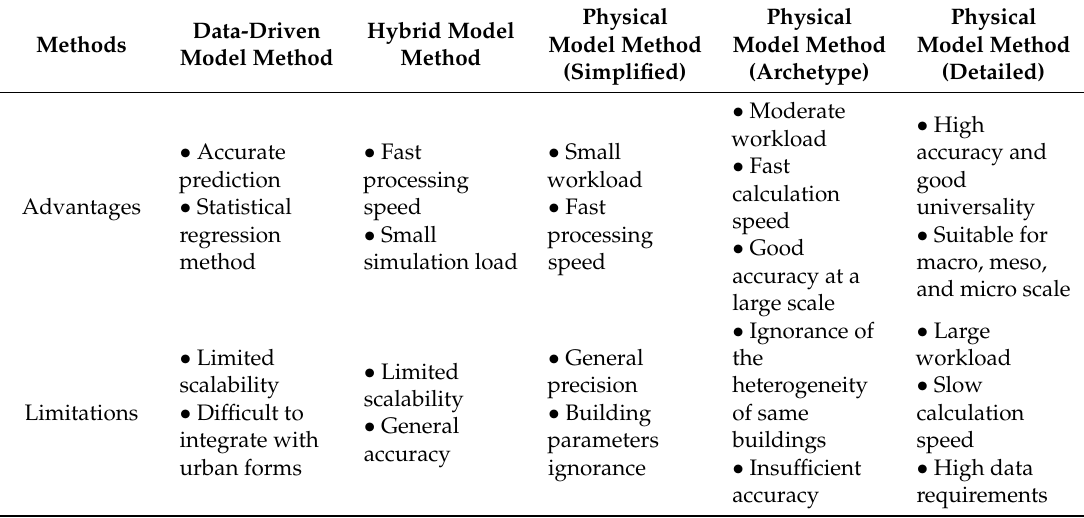
Table 1. Characteristics of bottom-up